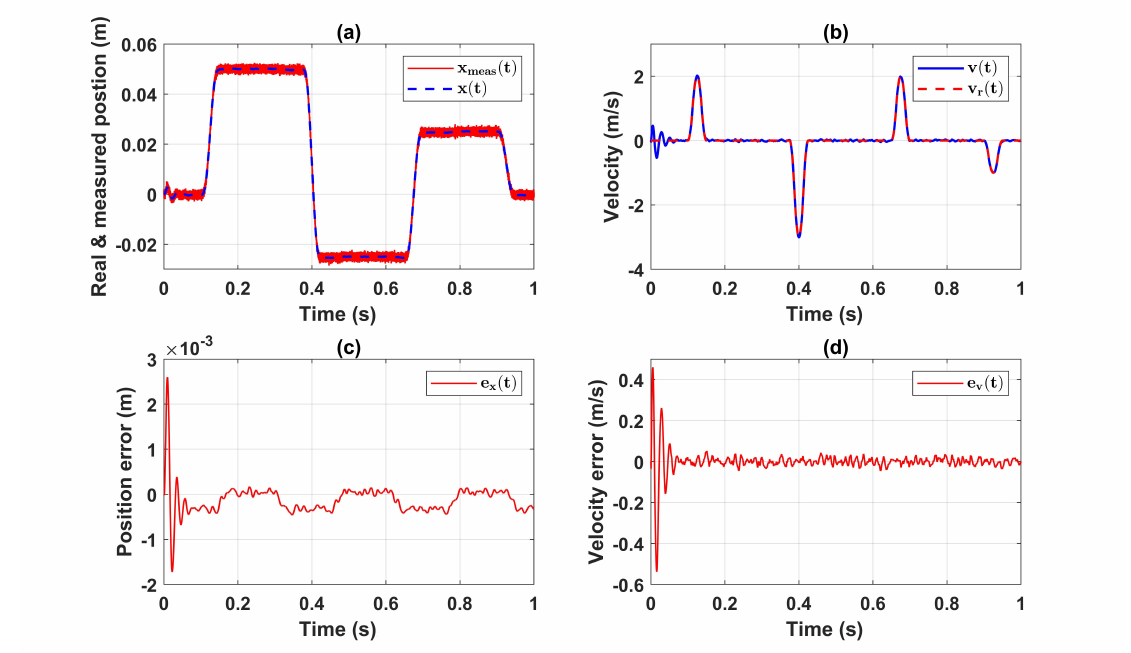
Figure 6. Effects of noise measurement in time response of ( a ) position tracking; ( b ) velocity tracking; ( c ) position error; ( d ) velocity error.